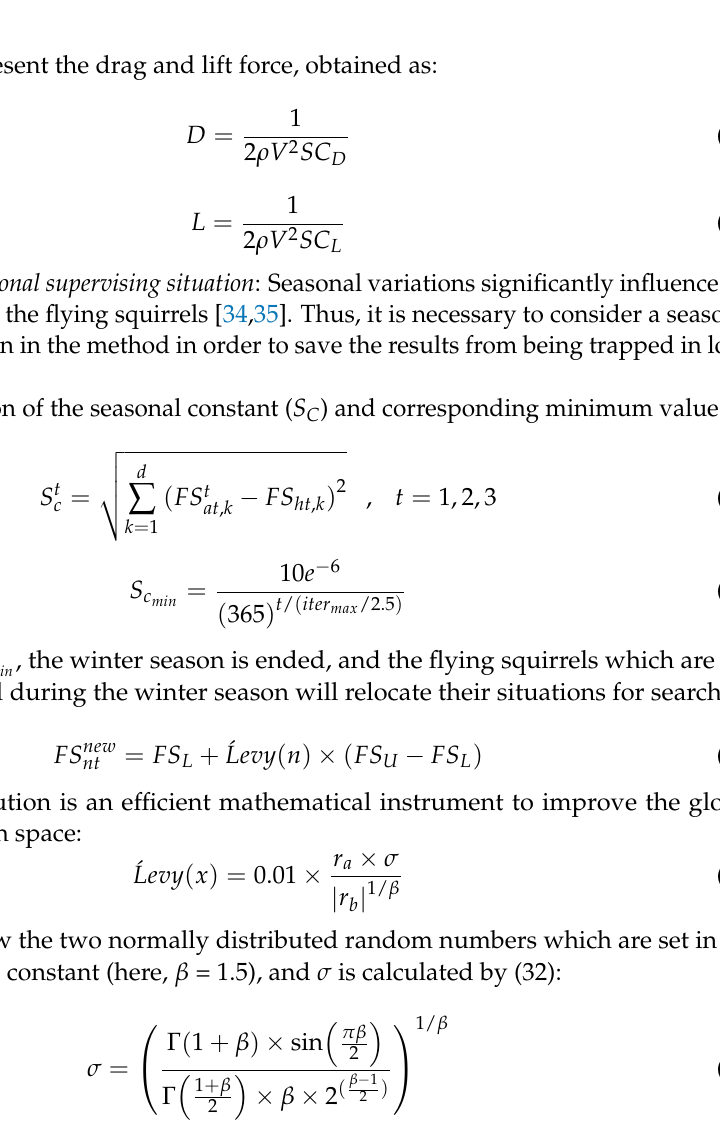
algorithm (FA), artificial bee colony (ABC) algorithm, bat algorithm (BA), particle swarm optimization (PSO), differential evolution (DE), and evolutionary programming (EP). The results indicated that SSA has the capability to bestow with better-quality solutions than other optimization